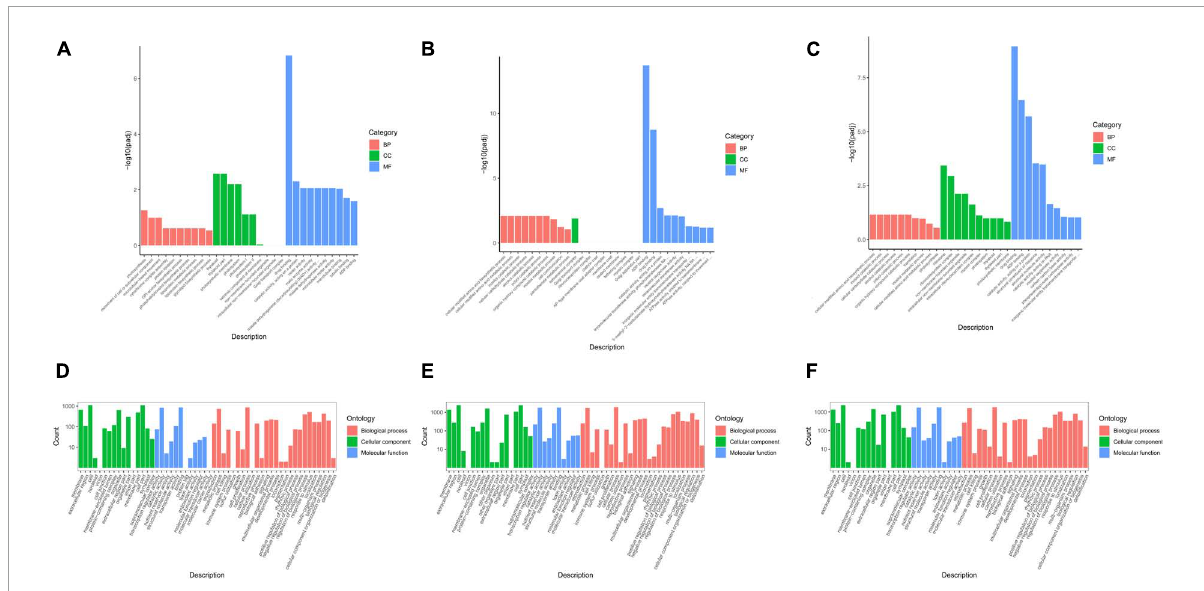
FIGURE3 Gene ontology (GO) enrichment analysis of differentially expressed genes (DEGs) in groups JP and YX. (A) Tea-20 vs. Tea-200, (B) Tea-20 vs. Tea-1200, (C) Tea-200 vs. Tea-1200, (D) Tea-50 vs. Tea-100, (E) Tea-50 vs. Tea-400, and (F) Tea-100 vs.